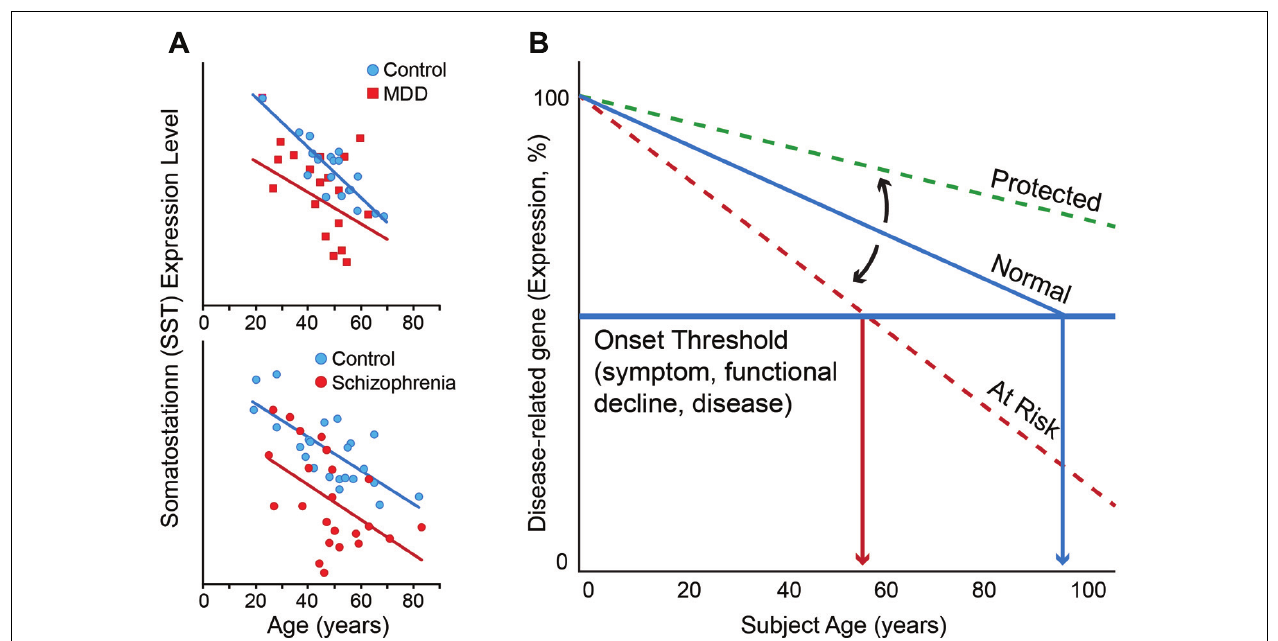
decrease is shown) across a threshold (horizontal blue line) marks the onset of disease symptoms. Changes in the trajectory of age-related changes in expression of disease-related genes (Y-axis) determine at what age (X-axis), or even if, an individual develops disease symptoms (vertical red arrows). Modulators (black arrows) may thus place an individual on “at risk” or “protected” trajectory. Per this model, individuals with LLD may have modulators, genetic or environmental, that place them on an “at risk” trajectory for developing mood symptoms. Figures are adapted from Morris etal. (2008),Tripp etal. (2011), Glorioso and Sibille (2011), and McKinney and Sibille